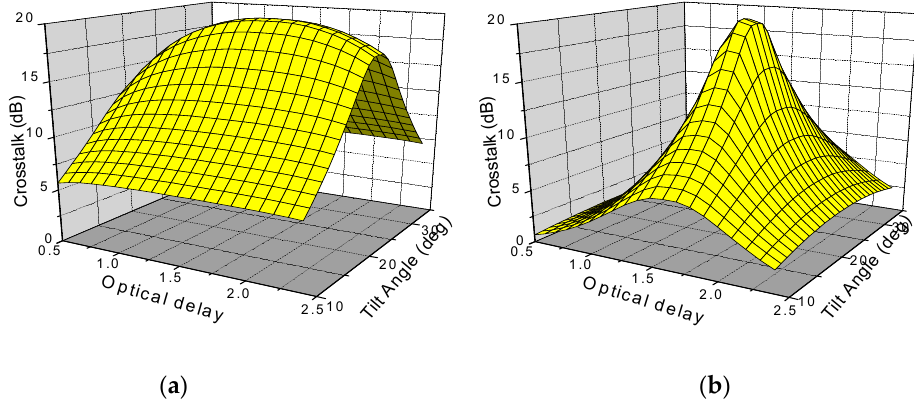
Figure 5. Simulated cross talk as a function of temperature dependent parameters θ (T) and ∆ n (T) of ( a ) crossed and ( b ) parallel polarised states.